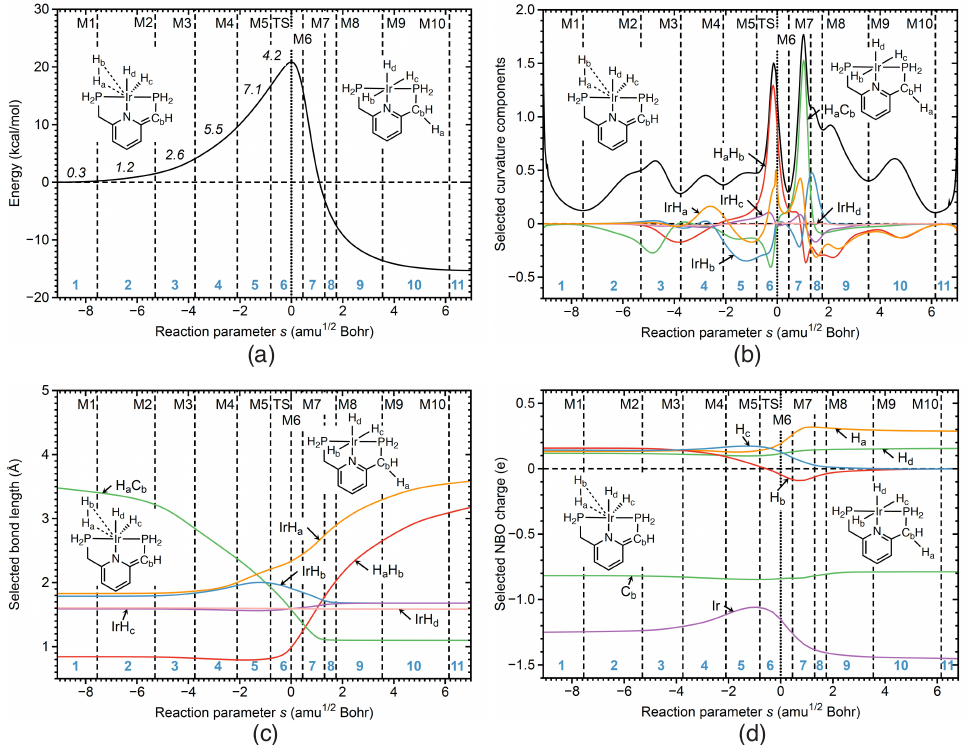
Figure 9. Properties of reaction R5 of the catalytic cycle along the reaction path. ( a ) Energy profile, energy contributions of each reaction phase to the activation energy are indicated by italic numbers; ( b ) decomposition of the reaction curvature into selected components; ( c ) change of selected bond lengths along s ; ( d ) change of selected NBO atomic charges along s . Positions of the curvature minima are shown as dashed vertical lines and are labeled as M1, M2, and so on. The position of the TS is indicated by a dotted line. Reaction phases are indicated by blue numbers. B3LYP/6- 31G(d,p)/SDD(Ir) level of